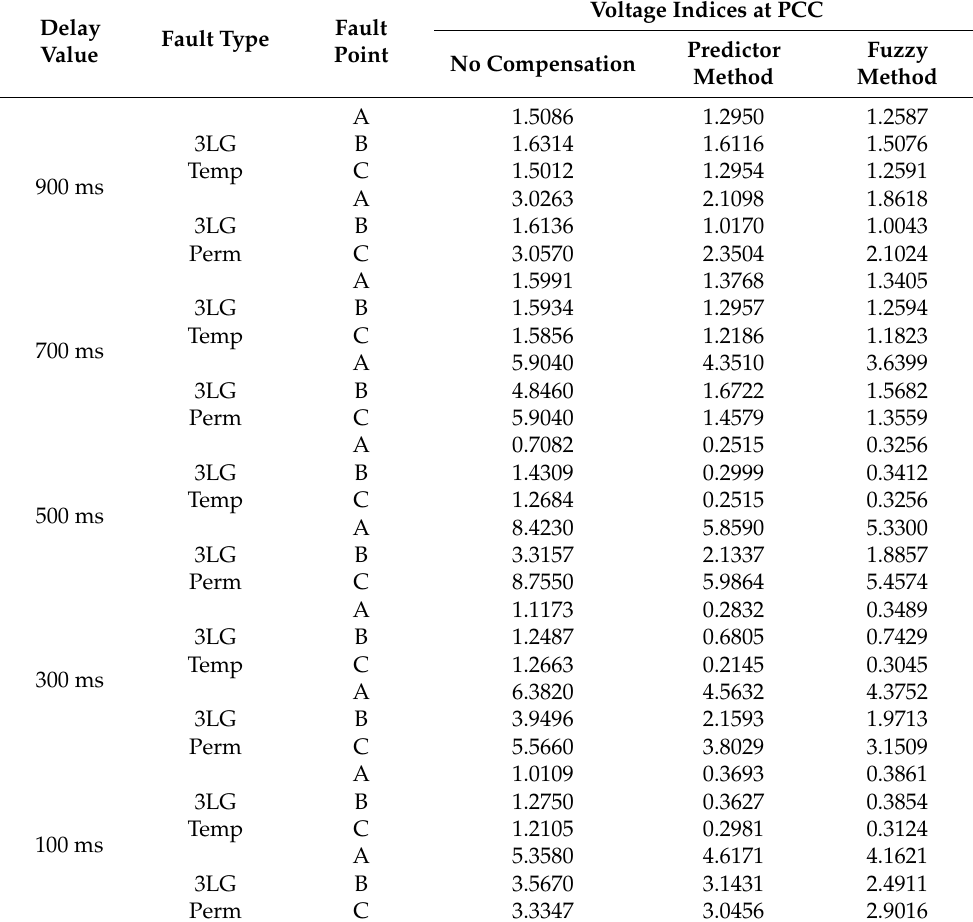
Table 7. Total harmonic distortion at PCC.